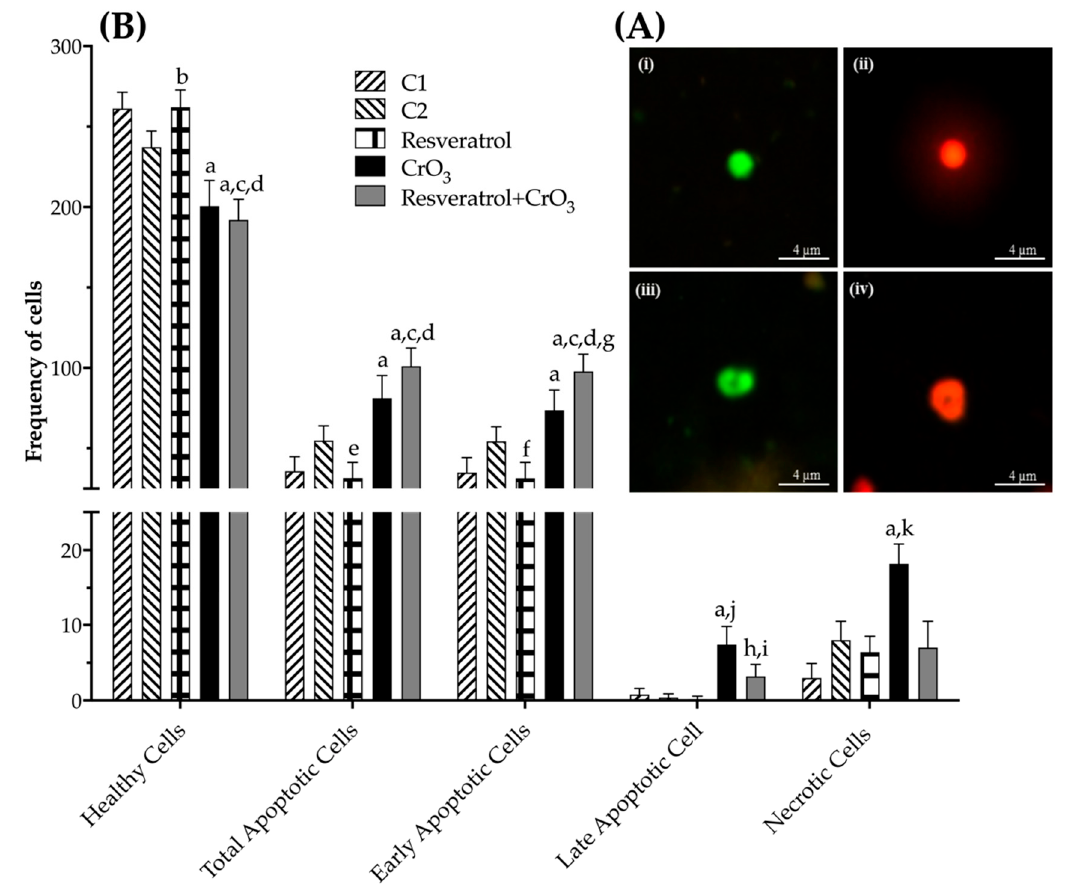
Figure 5. ( A ) Fluorescent microphotograph (400 × ) of peripheral blood cells using differential acridine orange/ethidium bromide (AO/EB) staining. ( i ) Healthy cell. ( ii ) Necrotic cell. ( iii ) Early apoptotic cell. ( iv ) Late apoptotic cell. ( B ) Effect of resveratrol and CrO 3 on the frequencies of healthy, apoptotic (total, early, and late), and necrotic cells in peripheral blood, evaluated 48 h after treatments. A total of 300 nucleated cells were evaluated in each mouse ( n = 5 mice/group). Statistical significance was determined using one-way ANOVA followed by Tukey’s post-hoc test: a p < 0.0001 vs. C1; b p <